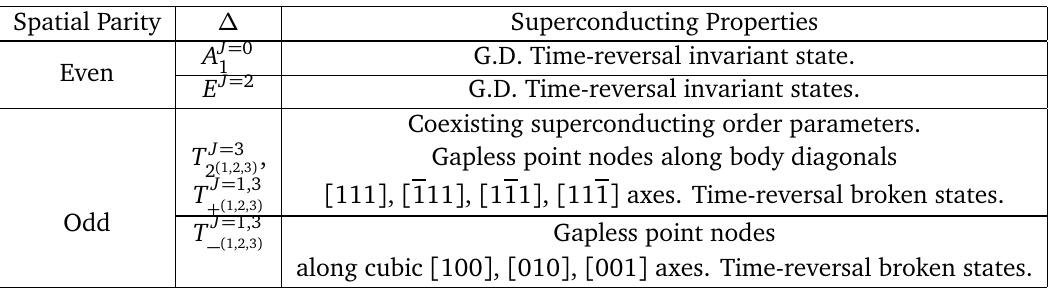
Figure 3: Superconducting order parameters arising from 1 i = 1,2,3 denoting the components of the three-dimensional irreps, from the novel fixed point Kondo interaction. Coupled order parameters have an intersection be- tween their depicted circles. The Cooper pair operators associated with the order parameters are detailed in Appendix E. The complete form of the pairing Hamilto- nian is presented in Appendix G.